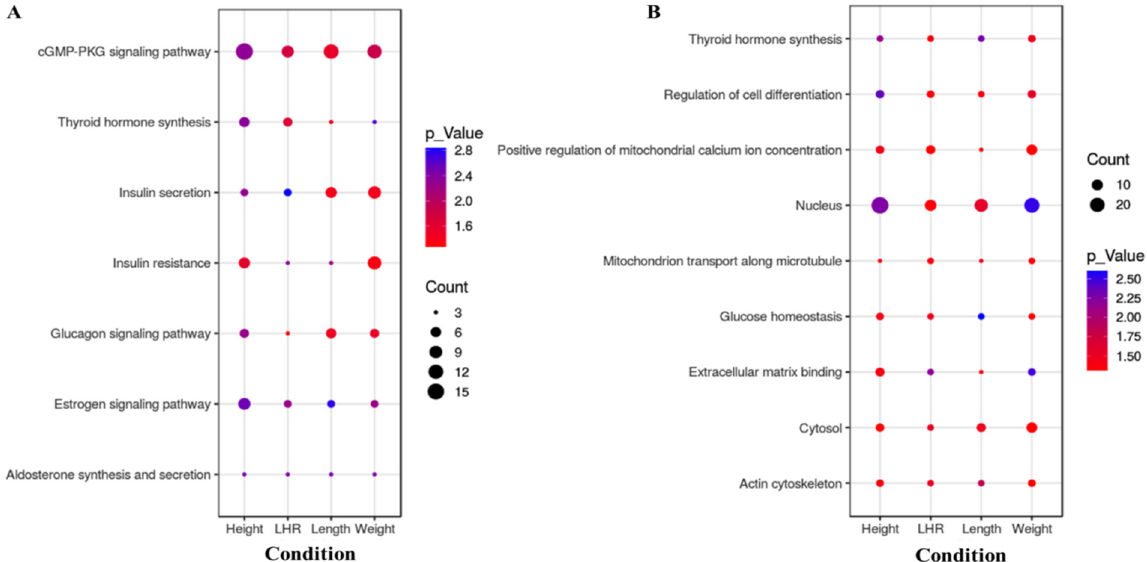
Figure 8. The significantly ( p < 0.05) enriched 7 KEGG pathways ( A ) and 9 GO terms ( B ) shared among traits.